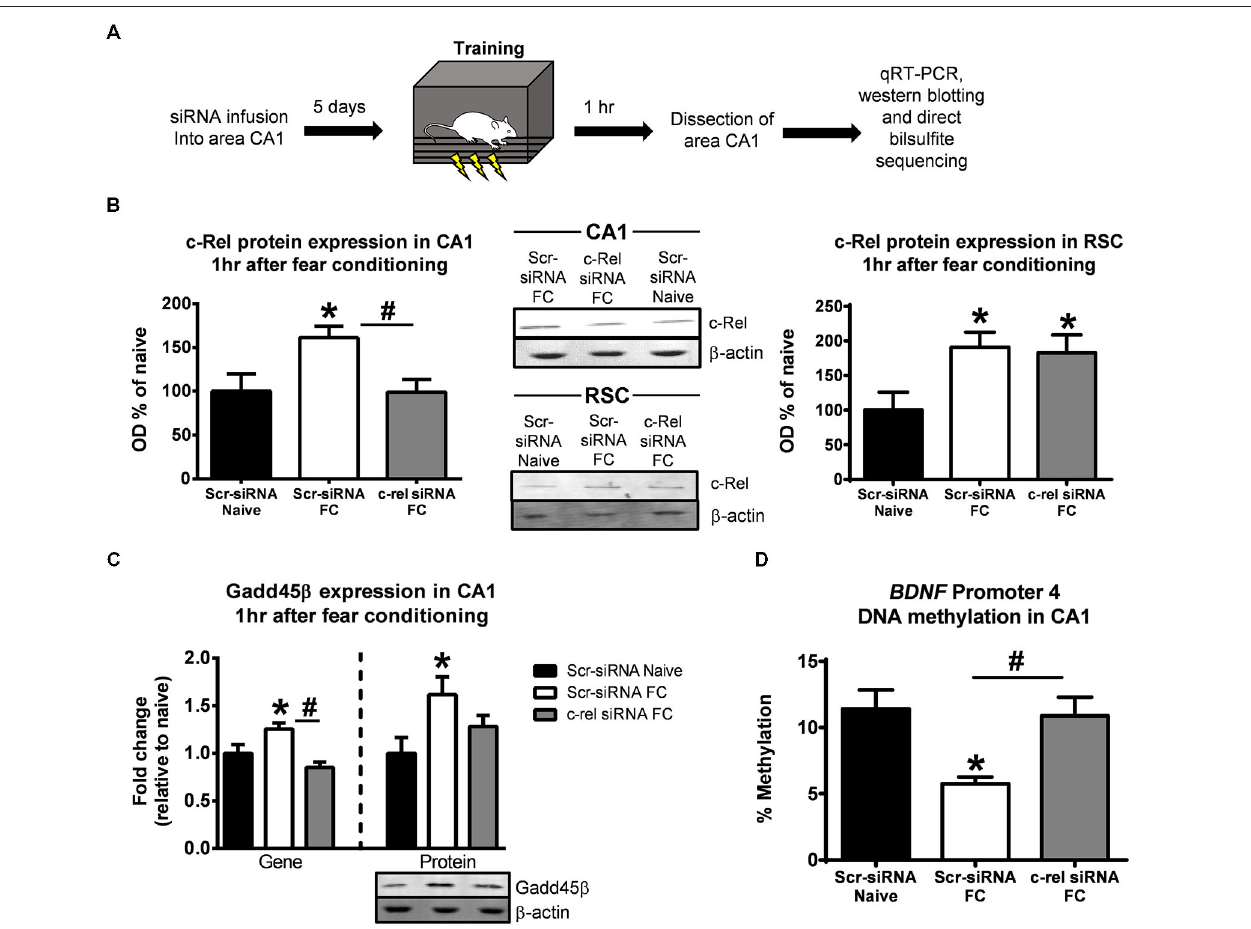
FIGURE 5 | Local knockdown of c-rel in the hippocampus prevents fear conditioning-induced changes in Gadd45 β expression and BDNF DNA methylation. (A) Rats were infused Accell siRNAs against c-rel or a negative control (Scr-siRNA) 5 days prior to fear conditioning and area CA1 collected 1 h later. (B) Fear conditioning increased c-Rel protein expression in the hippocampus which was blocked by the c-rel siRNA, confirming effective gene knockdown by the siRNA infusion (left). Fear conditioning-induced increases in c-Rel protein expression in the retrosplenial cortex (RSC) were not altered by the c-rel siRNA when infused in the hippocampus, confirming that the siRNA did not diffuse up the injection tract (right). (C) Knockdown of c-rel prevented the fear conditioning induced increases in Gadd45 β gene ( n = 3–4 per group) and protein expression ( n = 5 per group) in the hippocampus. (D) Knockdown of c-rel prevented the fear conditioning induced decreases in rat BDNF Promoter 4 DNA methylation in the hippocampus ( n = 3 per group). ∗ p < 0.05 Scr-siRNA Naïve. # p < 0.05 from Scr-siRNA